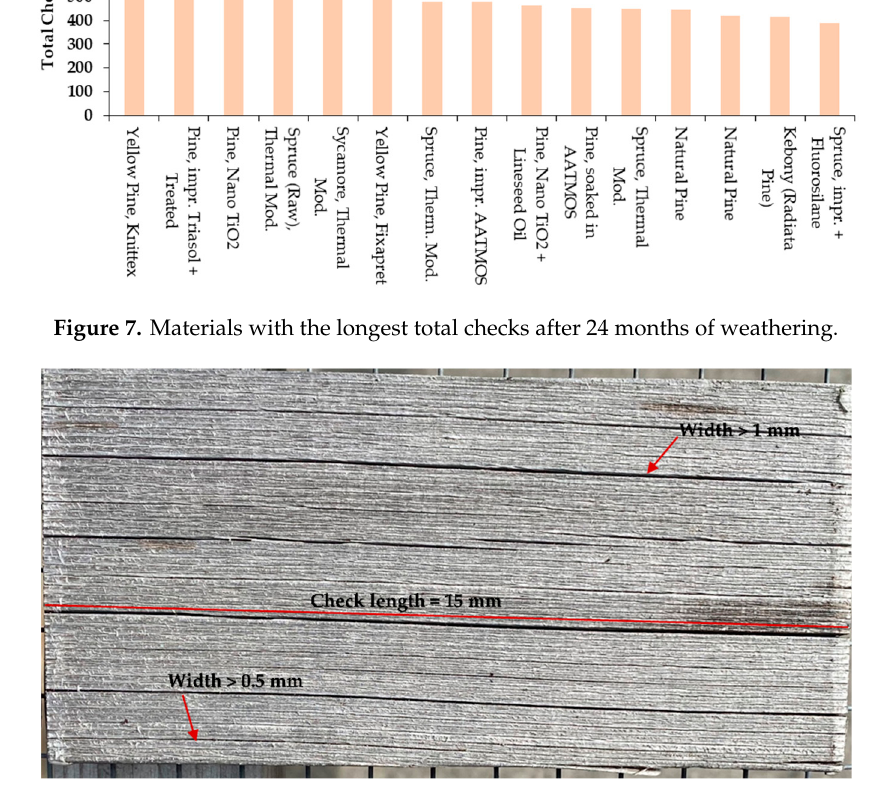
Figure 8. Visible cracks of nano TiO 2 -impregnated pine after 2 years of Figure 8 . Visible cracks of nano TiO 2 -impregnated pine after 2 years of weathering.